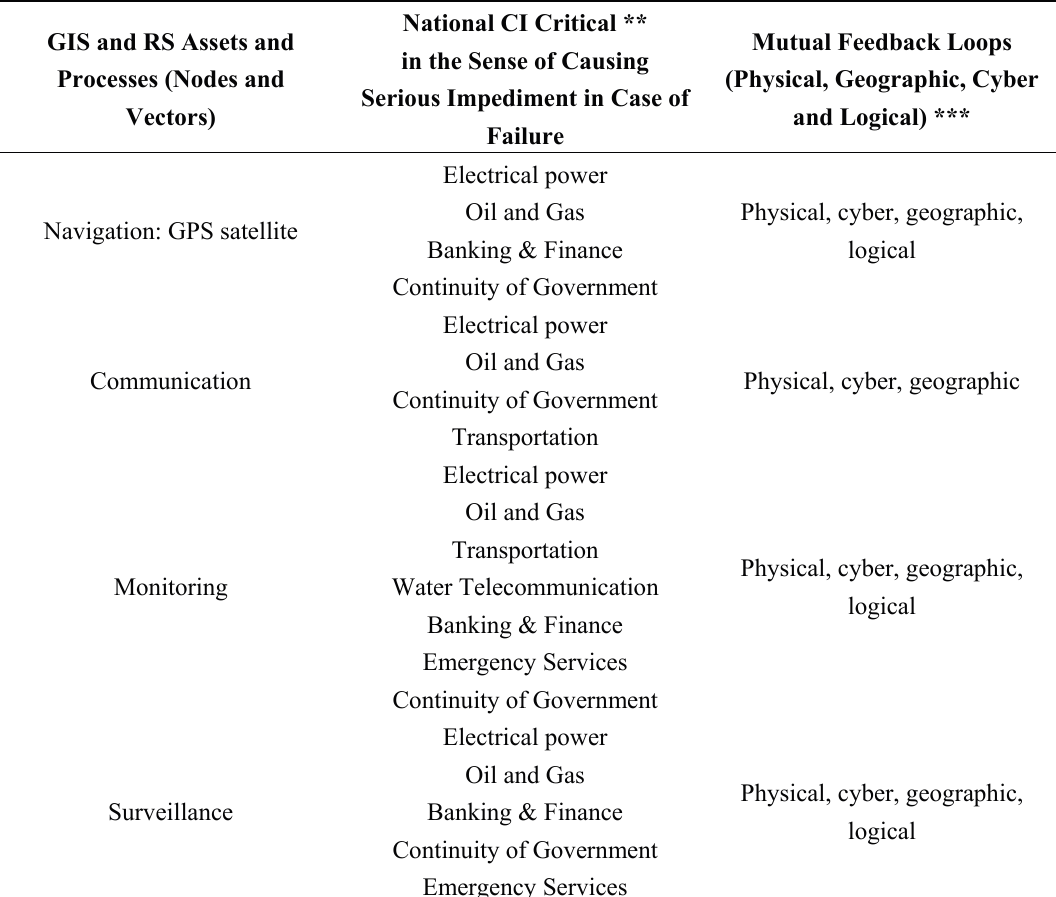
Table 2. Dependencies and interdependencies of GIS and RS with traditional National Critical